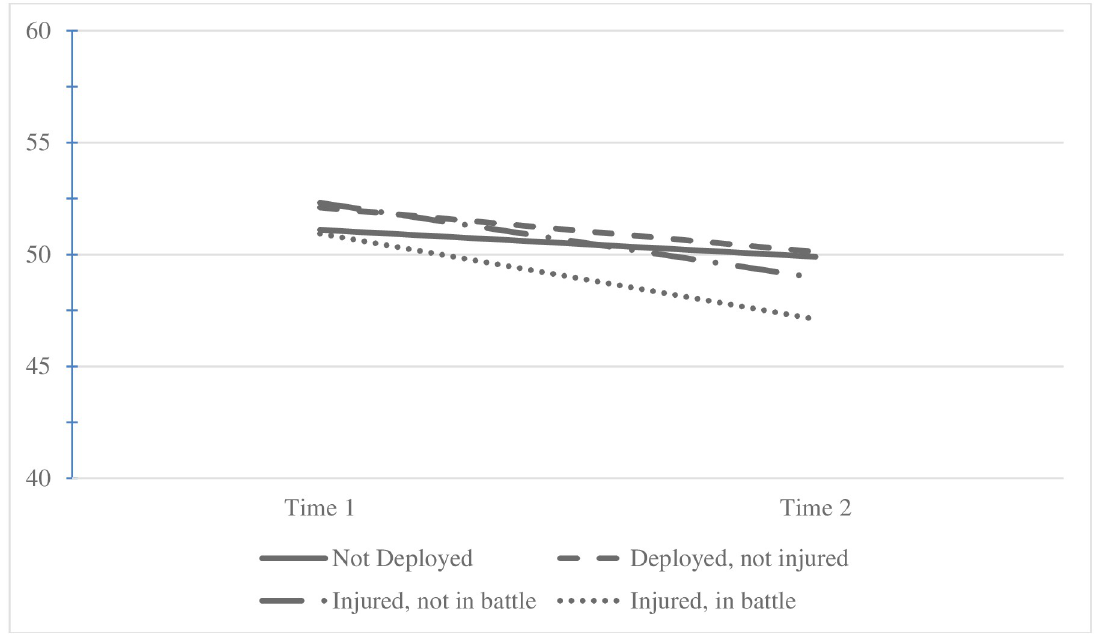
Fig 3. Average Mental Component Summary by deployment and injury status at Time 1 and Time 2. Mean MCS at Time 1 varied by deployment and injury status (mean of 51.1 for ND, 52.1 for DNI, 52.3 for DNBI, and 50.9 for DBI; p-value < .0001; Table 1 and Fig 3) and pairwise comparisons using Tukey multiple comparison procedu res revealed a significant (p-value < 0.05) group difference between ND and DNI’s mean scores. Mean change in MCS between Time land Time 2 also varied significantly by deployment and injury status (mean change for ND -1.2, DNI -2.0, DNBI -3.3, and DBI -3.8; p-value < .0001; Table 1 and Fig 3). Pairwise comparisons revealed three significant (p-value < 0.05) group differences in the change in MCS between those ND and the three deployed groups. Finally, mean MCS at Time 2 varied significantly by deployment and injury status (Table 1 and Fig 3) and pairwise comparisons revealed three significant differences (p-value < 0.05) in mean MCS at Time 2 between 1) ND and DNI, 2) DNI and DBI, and 3) ND and DBL.